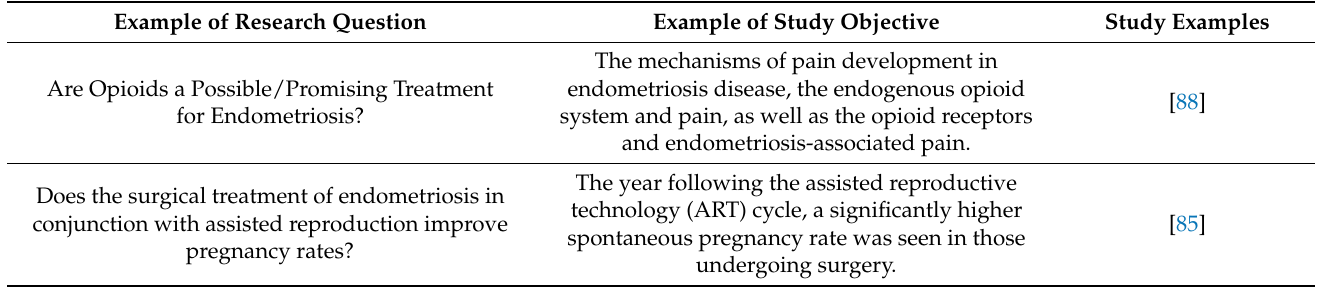
Table 3. Endometriosis